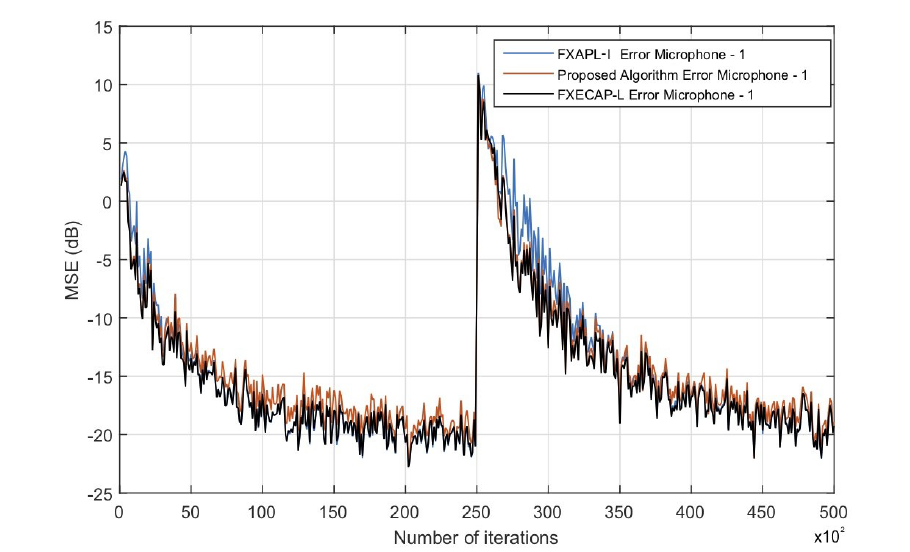
Figure 2. Comparison of the MSE curves for the FXAPL-I, FXECAP-L and the proposed algorithm.